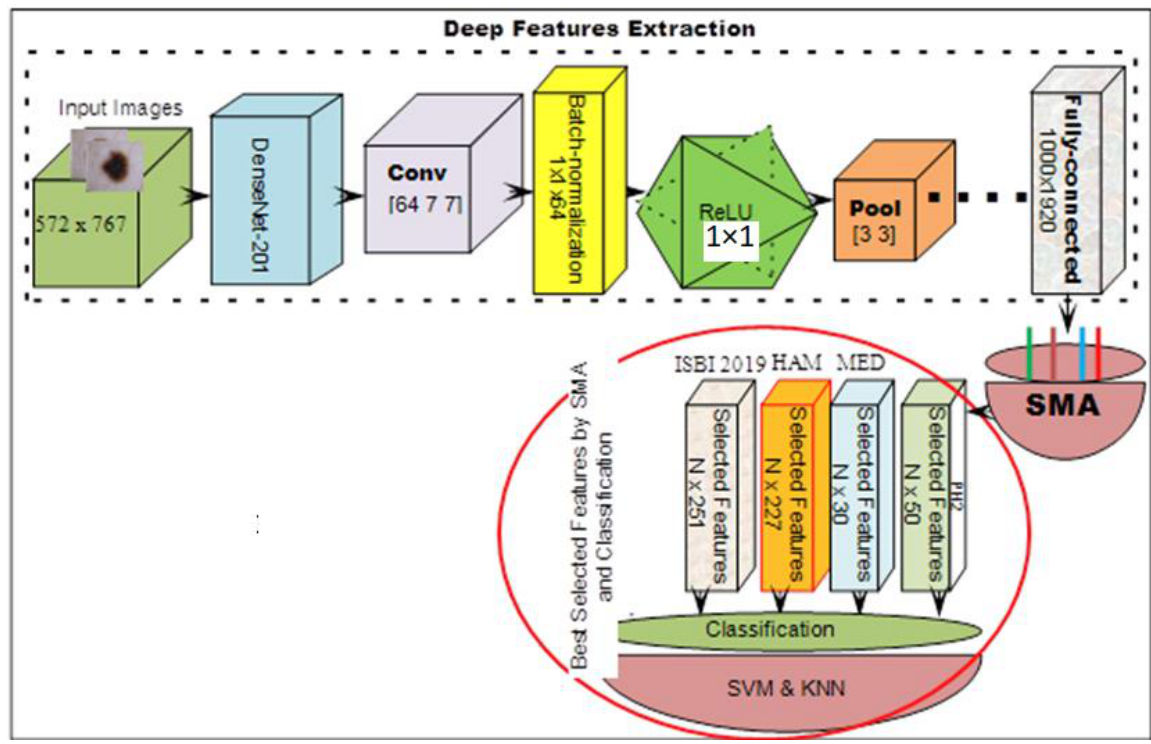
Table 3. Selected numbers of features in each dataset.